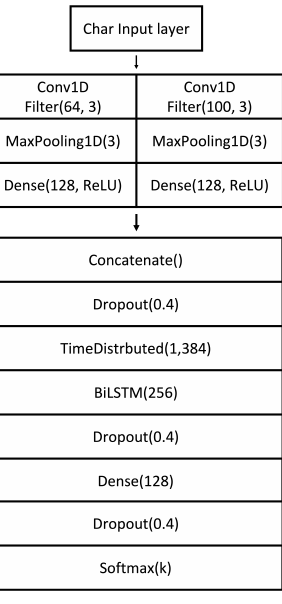
Figure 2. The architecture of CNN